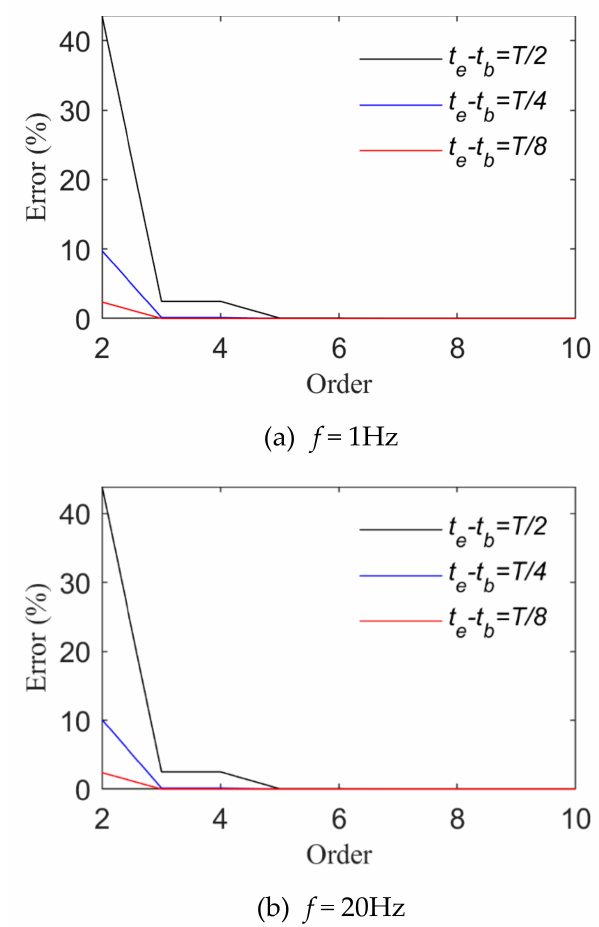
Figure 3. Fitting effects of harmonic loads (Case 1).